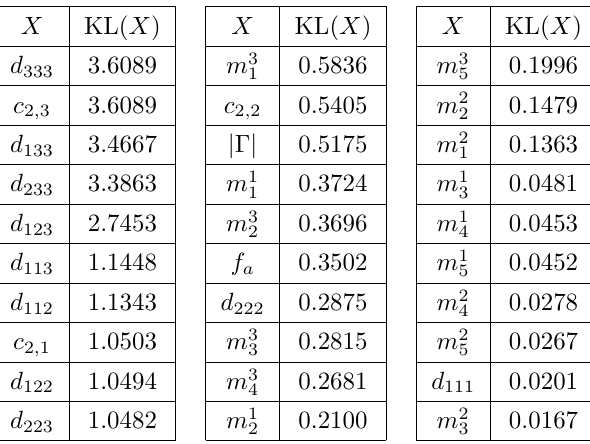
Table 3 . KL divergence of each